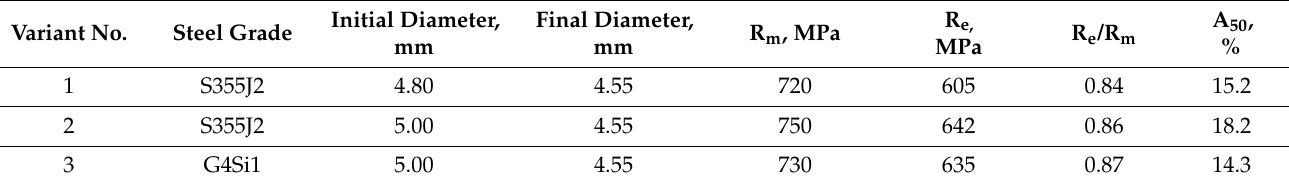
Table 7. Mechanical properties of wires after the calibration drawing process. Variant